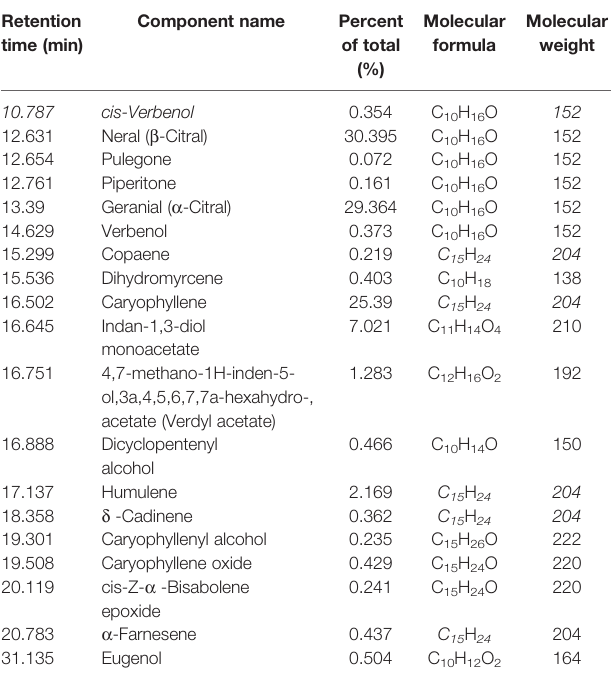
TABLE 2 | Major components of lemongrass essential oil